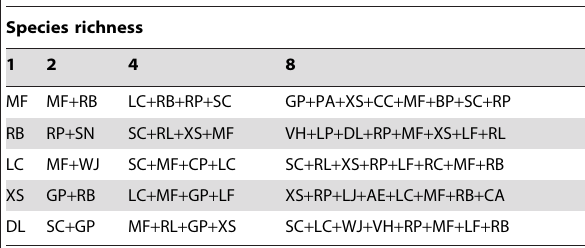
Footnotes: Species abbreviations and their corresponding full names are listed in Table